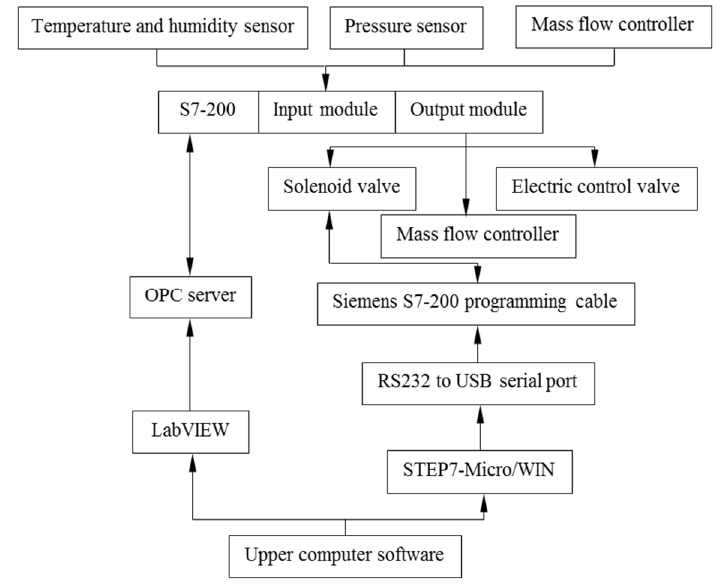
Figure 10. Communication flow chart.